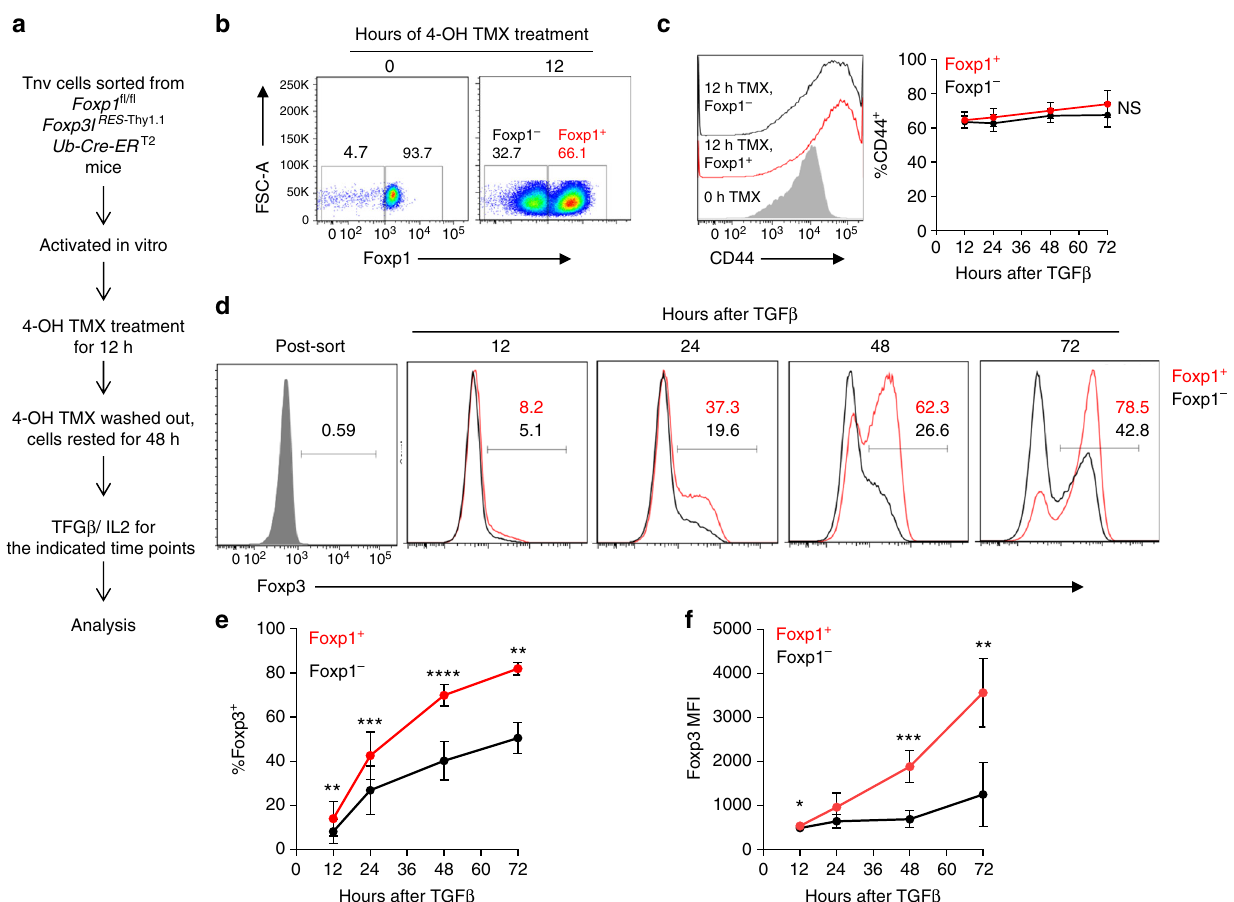
Fig. 4 Early stage of Foxp3 induction in iTreg cells also require Foxp1. a Experimental scheme. FACS sorted Thy1.1 − Tnv cells from Foxp1 f/f Foxp3 IRES- Thy1.1 Ub Cre-ERT2 mice were activated in vitro with 1 μ g/ml of plate-bound anti-CD3 and CD28 in the presence of 0.3 µ M 4-OH tamoxifen and 50 IU/ml of IL-2. After 12 h, cells were washed, rested for 48 h, and subsequently treated with TGF- β , and the expression of Foxp3 was analyzed at the indicated time points within live Foxp1-suf fi cient and Foxp1-de fi cient cells. b Representative FACS plot indicating 4-OH TMX-mediated deletion of Foxp1 within a subset of cells after 48 h is shown, which were gated as Foxp1-suf fi cient and Foxp1-de fi cient populations in order to quantitate iTreg induction. c Representative FACS plots and quanti fi cation of CD44 expression in Foxp1 + and Foxp1 − populations throughout the course of the experiment. d Representative FACS plots to compare Foxp3 expression at the indicated time points between Foxp1-suf fi cient and Foxp1-de fi cient populations generated in culture after 4-OH tamoxifen treatment. e Quanti fi cation of percentage of Foxp3 induction. f Quanti fi cation of Foxp3 ’ s MFI. Data are representative of four